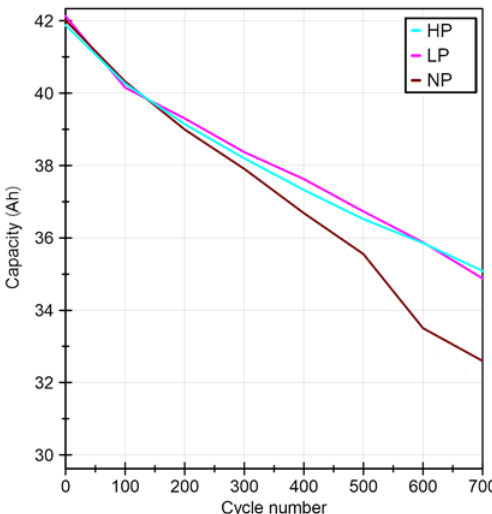
Figure 3. Capacity loss over cycle number for batteries cycled with/without applied pretension. Table 4. Residual capacity and SOH after